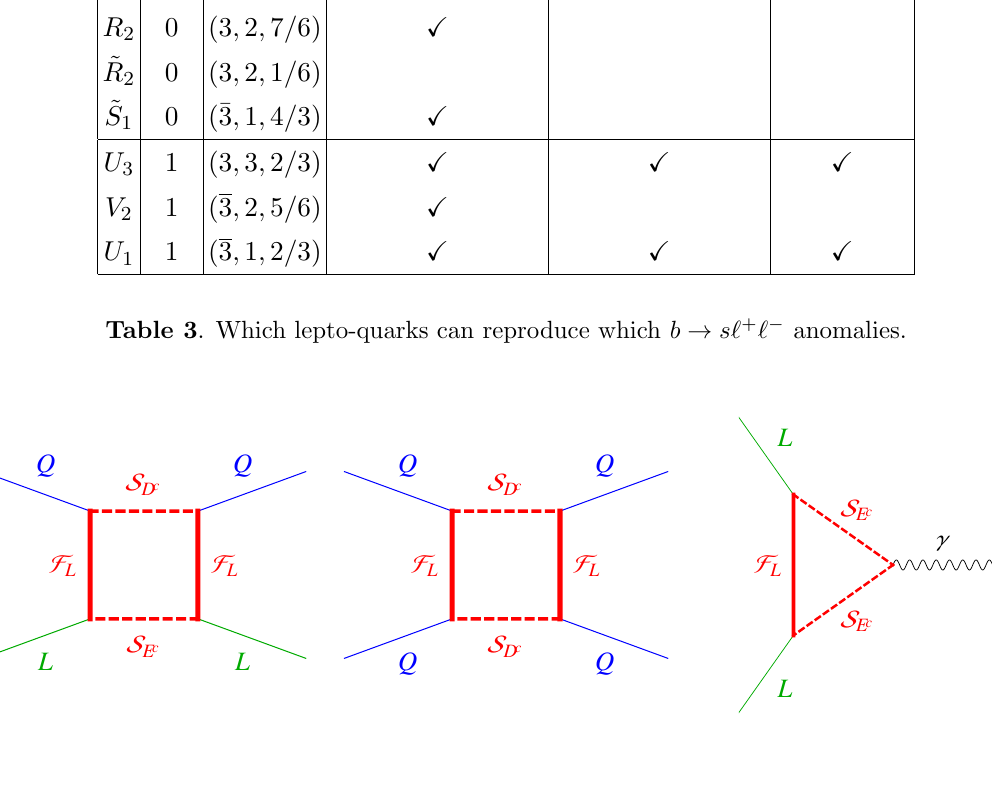
and the muon g 2 in models with extra s (cid:0)